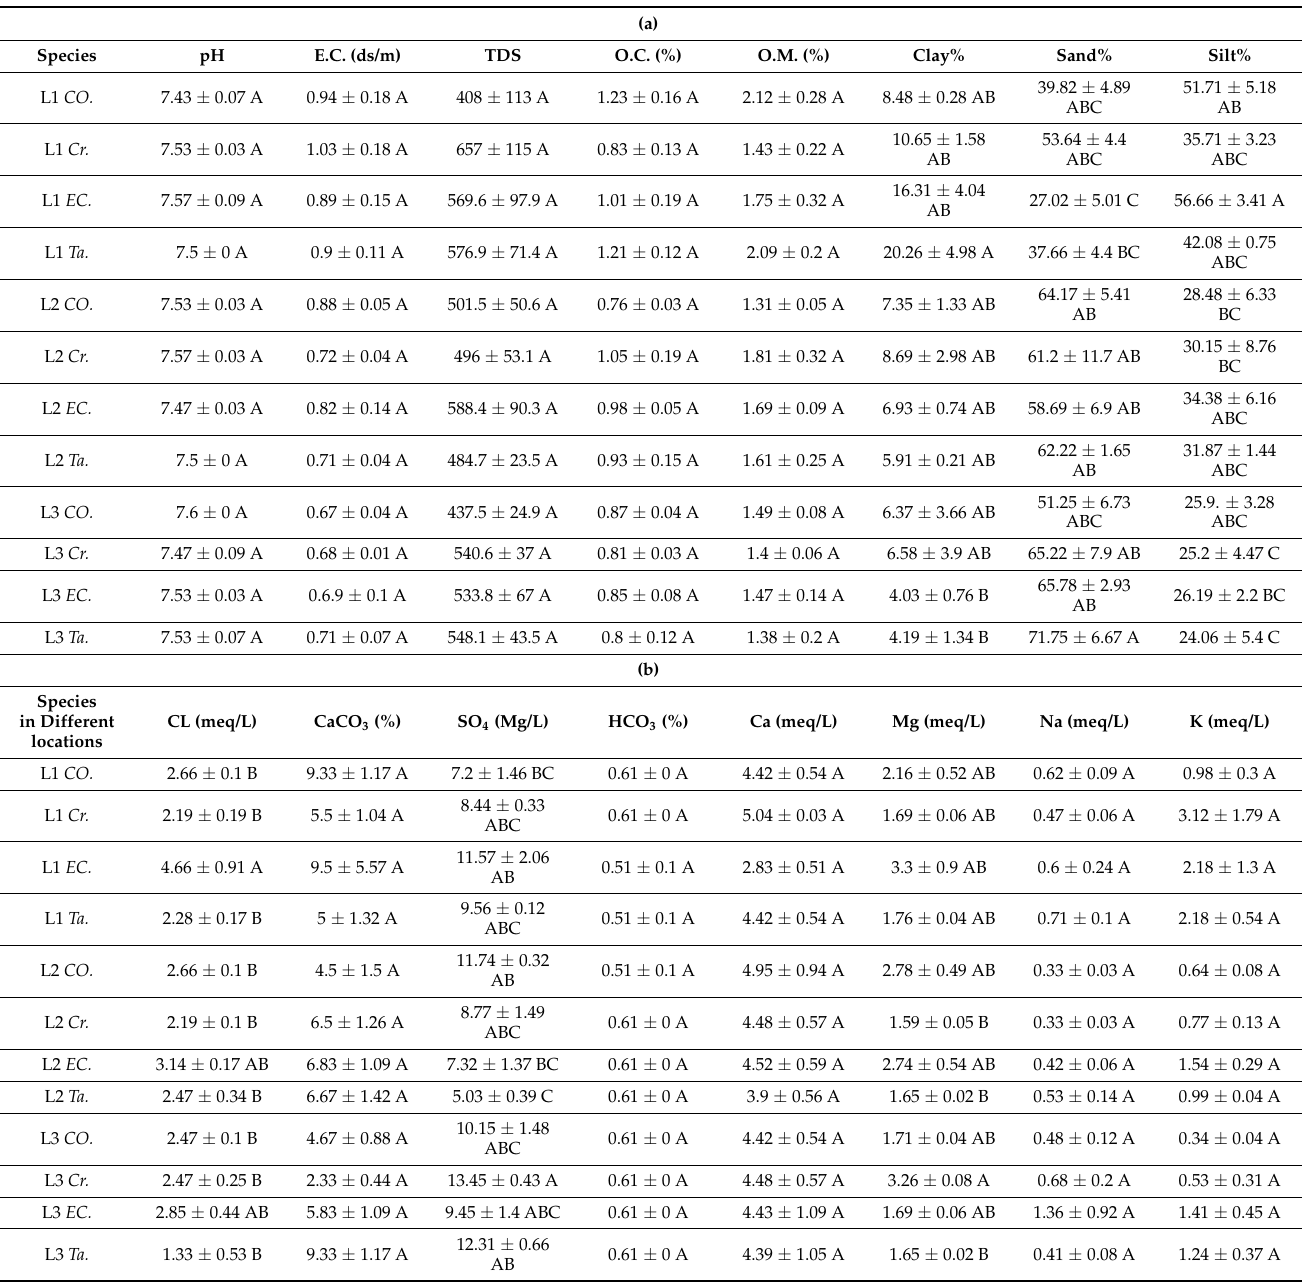
Table 2. ( a ) Mean ± SE of soil samples characteristics (pH, E.C, TDS, O.C, O.M, clay, sand, and silt contents) for the studied species at different altitudes. Abbreviations: L1 = altitude 1; L2 = altitude 2; L3 = altitude 3; Co . = Cotineaster orbicularis ; Cr. = Crataegus sinaica; Ec. = Echinops spinossissmus; Ta. = Tanacetum sinaicum. ( b ) Mean ± SE of the chemical analysis of soil samples (anions and cations content) for the studied species at different altitudes. Abbreviations: L1 = altitude 1; L2 =